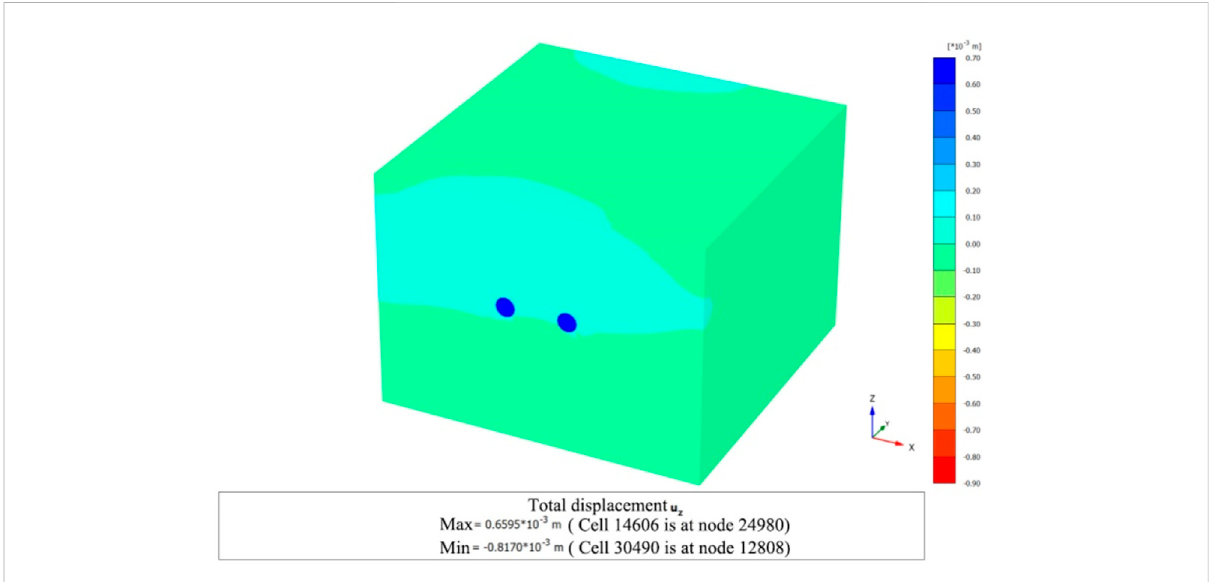
FIGURE 16 Vertical displacement nephogram of the soil in connecting aisle No.10.